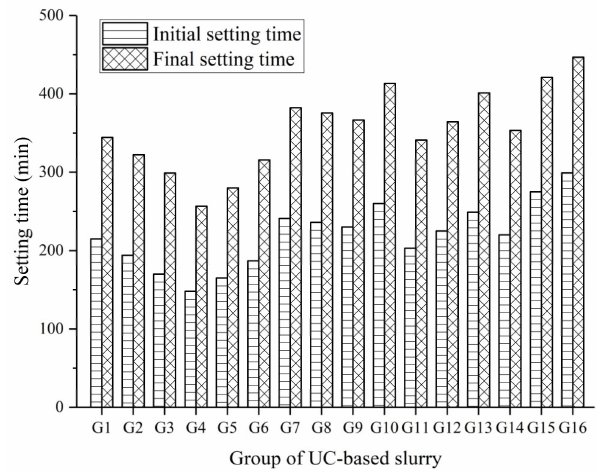
Figure 10. Initial and final setting time of the UC-based